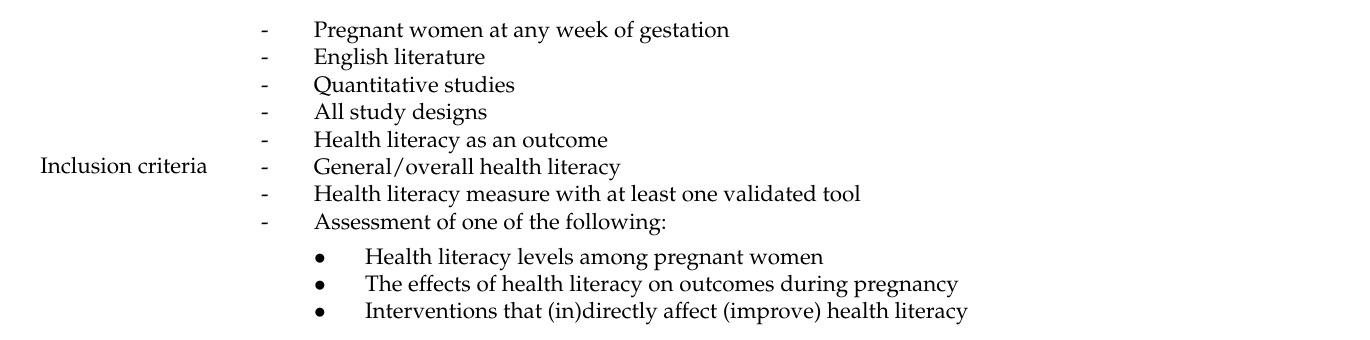
Table 1. Inclusion and exclusion criteria and search